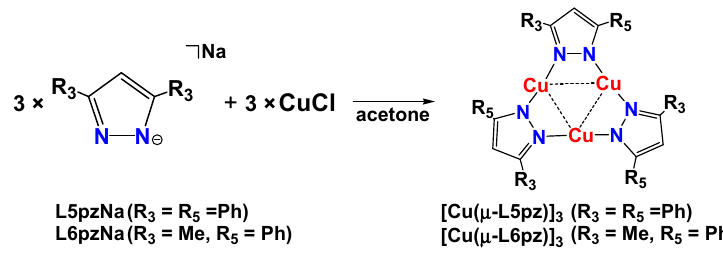
Figure 3. Synthesis of cyclic trinuclear pyrazolato Copper(I) complexes.